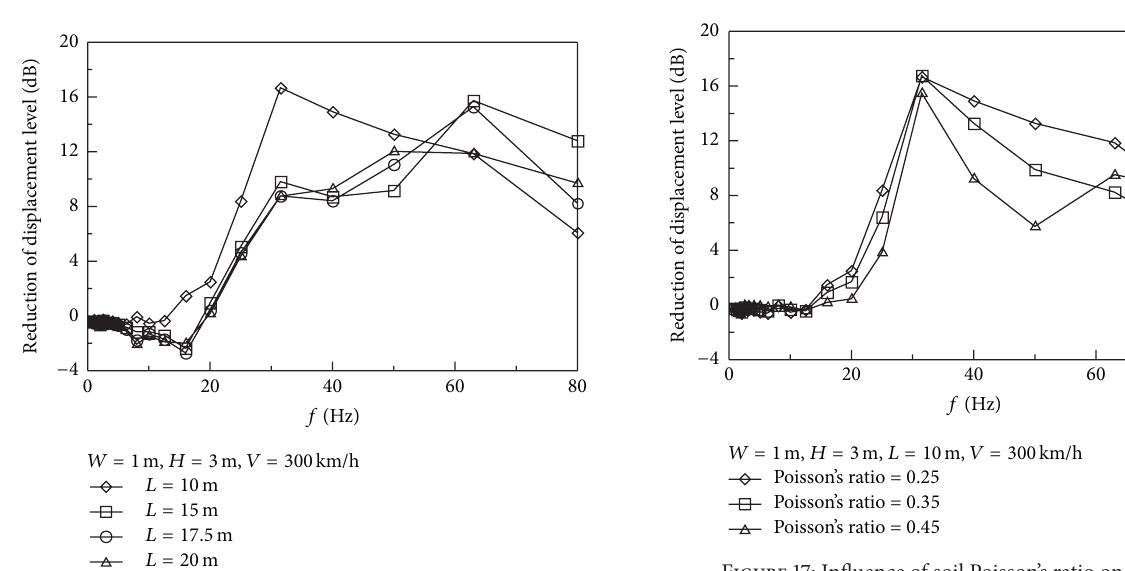
Figure 17: Influence of soil Poisson’s ratio on